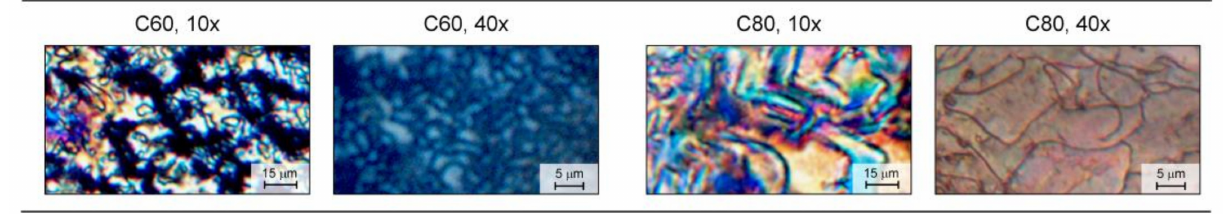
Figure 10. Micrographs of C60 and C80 frozen melts in crossed polarizers with 10 × and 40 × magnification after heating the samples to 375 ◦ C and subsequent cooling to room temperature.